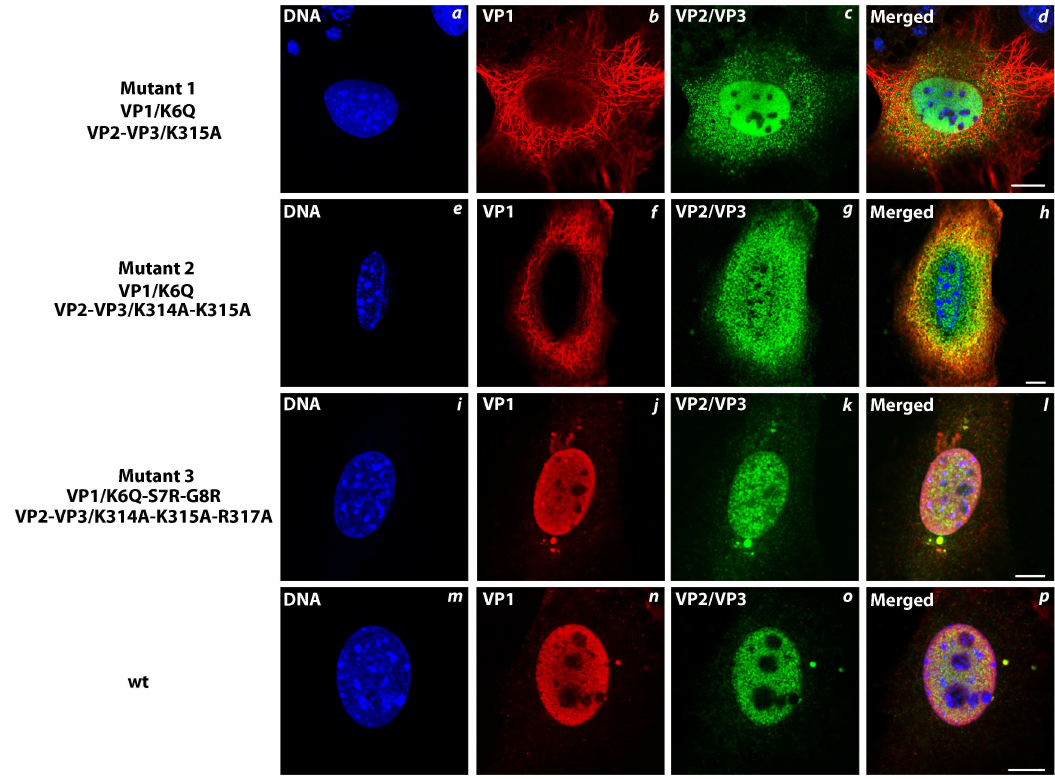
Figure 6. Effect of mutations in NLS of MPyV structural proteins VP1, VP2, and VP3 on their cellular localization during infection. Confocal sections of 3T6 cells infected with wt ( m – p ) or mutated viruses 1 ( a – d ), 2 ( e – h ), or 3 ( i – l ). Cells were fixed at 24 hpi and stained by antibodies against VP1 (red), VP2/3 (green), and DNA by DAPI (blue). Bars 5 µ